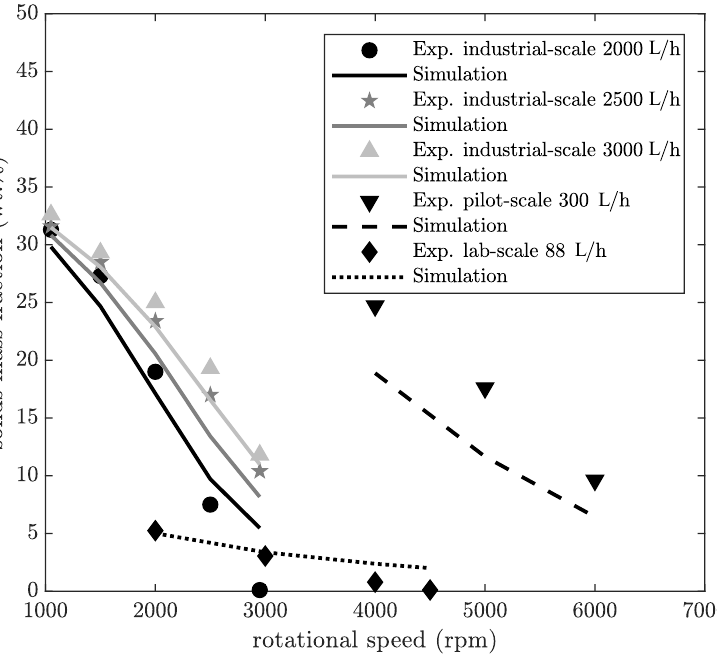
Figure 7. Solids mass fraction of the centrate for three decanter centrifuge scales, volumetric flow rates, and rotational speeds: Comparison of simulation and experiment for